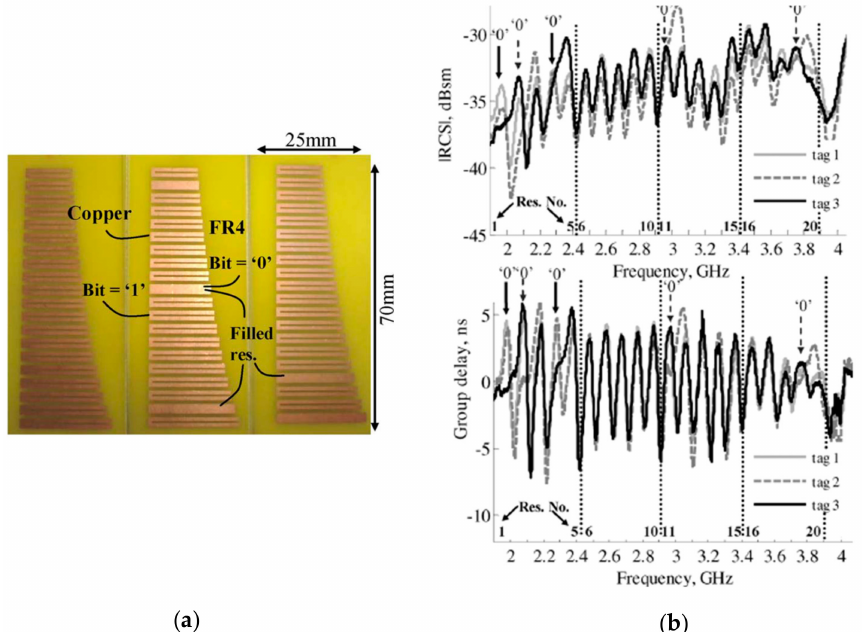
Figure 18. ( a ) Photograph and ( b ) measured radar cross section (RCS), and group delay of three di ff erent 20-bit tags implemented by Vena et al. Figure extracted from